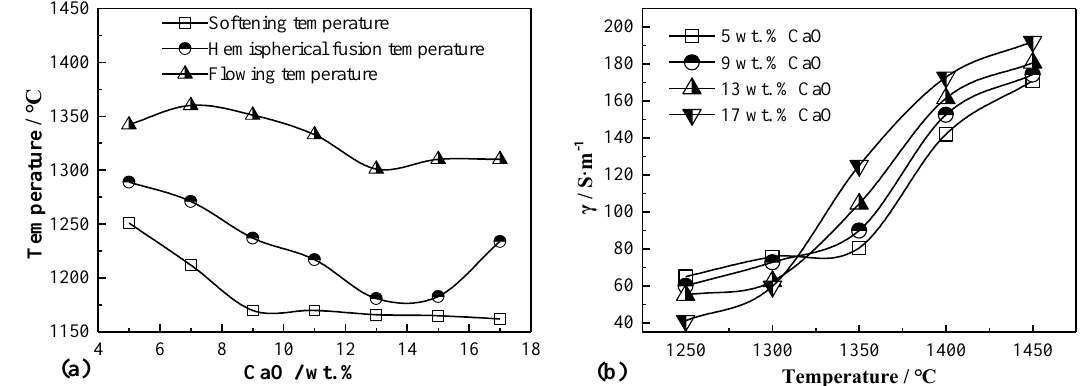
Figure 3. Effect of CaO in nickel slag of Fe x O-SiO 2 -CaO-MgO-“NiO” ( a ) melting characteristic; ( b ) electric conductivity.